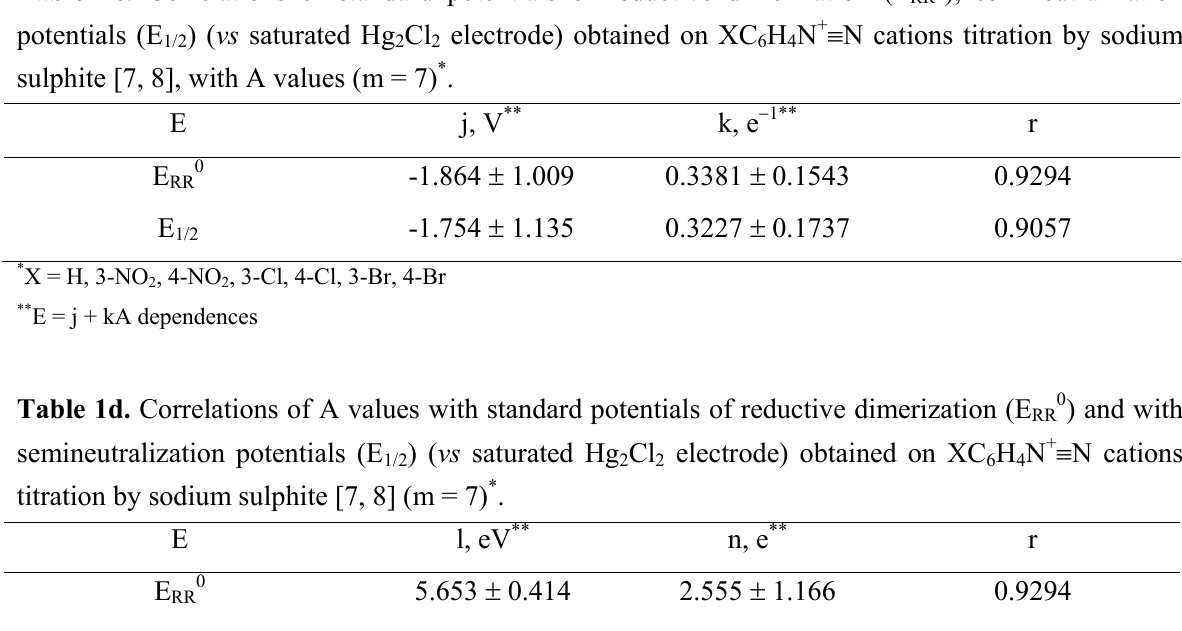
H N + ≡ N cations titration by sodium 6 4